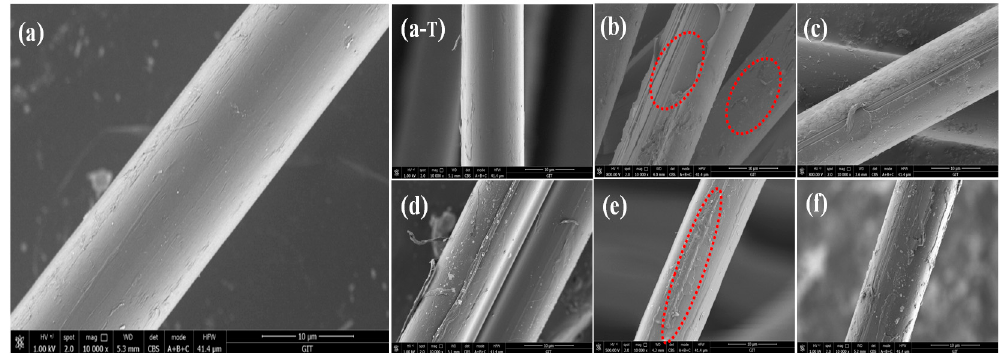
Figure 11. SEM images of aramid fiber before and after modification. (( a ) AF0; ( b ) AF1; ( c ) AF2 without scCO 2 processing; ( d ) AF2; ( e ) AF3 without scCO 2 processing; ( f ) AF3; ( a - T ) : AF0 sample were treated under 150 °C for 1 h).